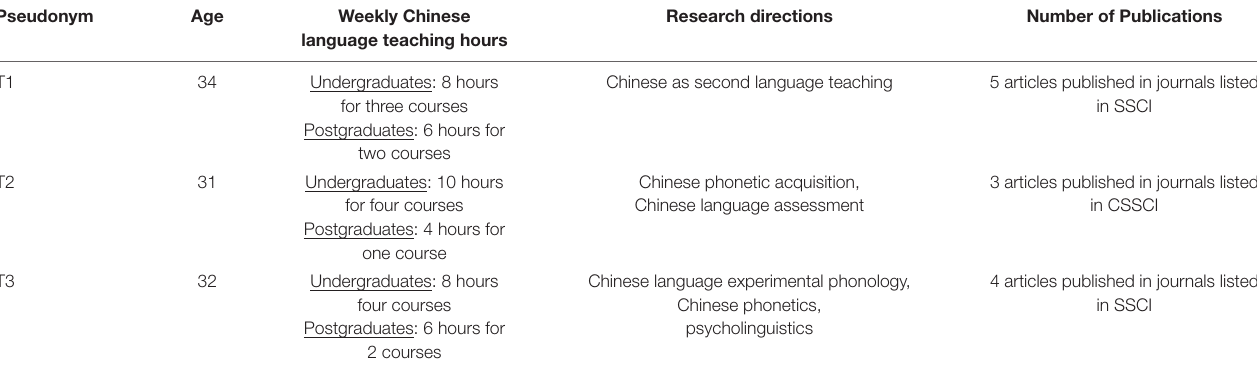
TABLE 1 | Participant profile.